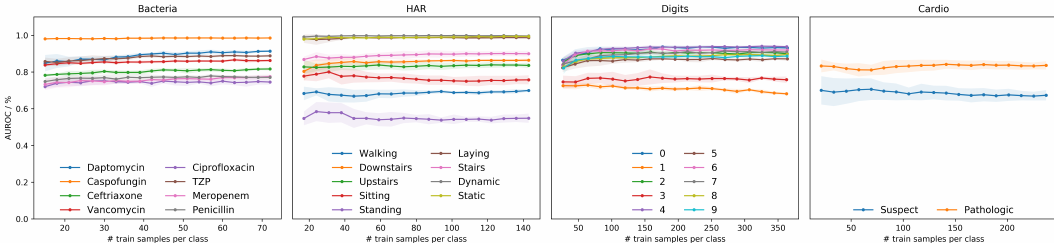
Figure 6. Ablation study of the KUE method, with KDE, for the four datasets. The legend represents each OOD inputs combination, and the title of each plot represents the dataset